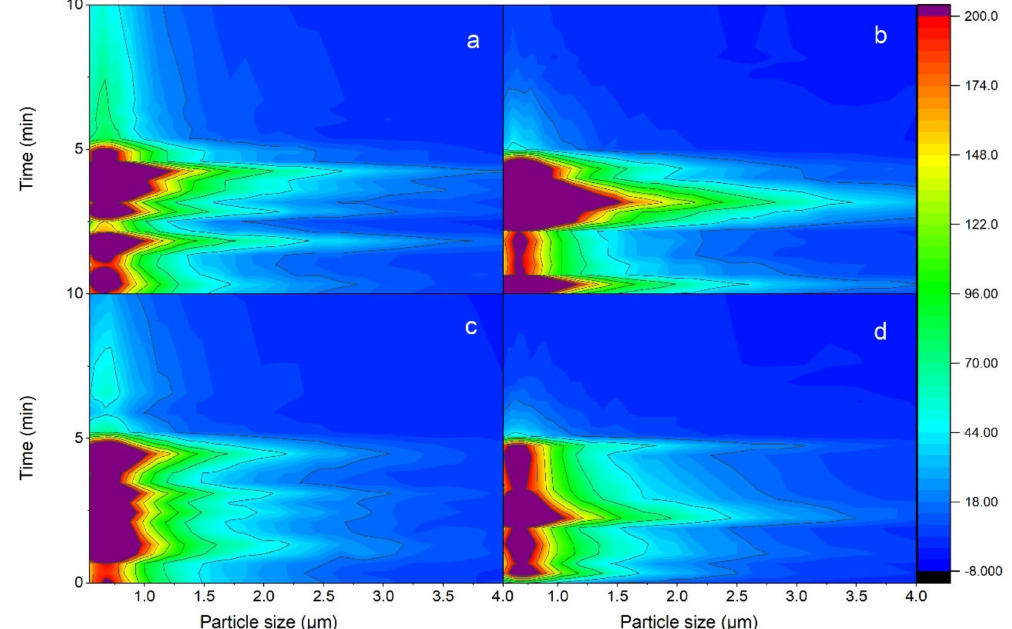
Figure 3. Concentrations of particles from 0.5 to 4 µ m in the first 10 min measurement with ( a , b ) closed door with ( a ) air purifier off and ( b ) high-speed air purifier turned on from the beginning of particle generation; and ( c , d ) open door with ( c ) air purifier off and ( d ) high-speed air purifier turned on from the beginning of particle